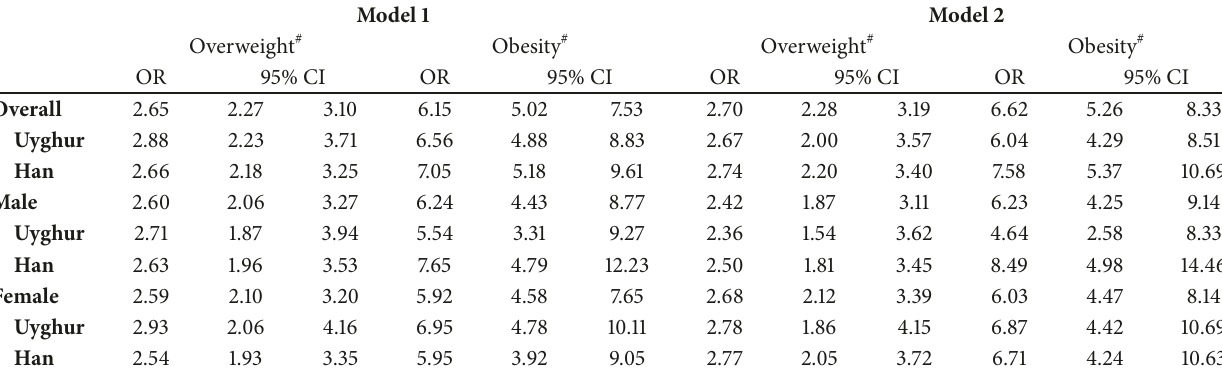
Uyghur 10.69 Han 4.24 10.63 ∗ In Model 1, only age and sex were adjusted. In Model 2, covariates were selected differently based on varied logistic regression models. For the overall model, ethnicity, sex, age, residential areas, educational attainment, family history of hypertension, smoking status, alcohol drinking, physical activity, FPG and TC were adjusted. For male and female adults, covariates were included separately in the model except sex. The ethnic- and sex-specific logistic model included covariatesexcept ethnicity andsex. Forfemale participants, smokingstatus andalcoholdrinking were not includedascovariates becauseofthe limitednumber. Age was set as continuous covariate, and other variables were set as indicators. # reference group=under/normal